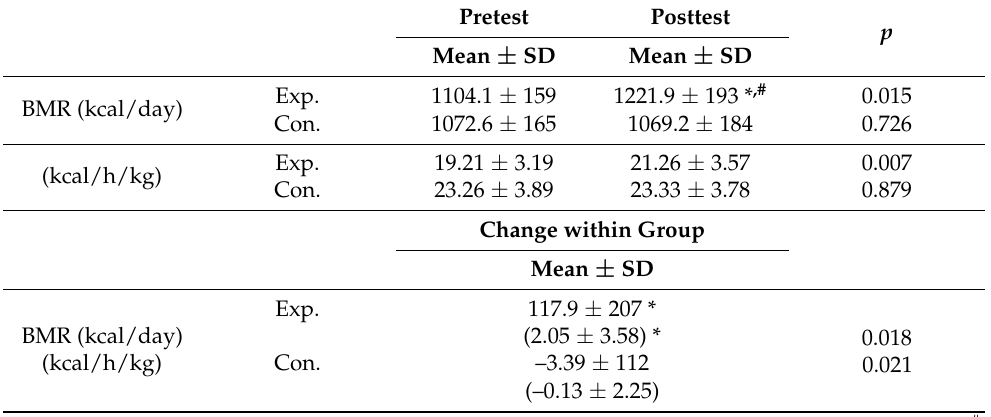
Table 5. Effects of 12-week Pilates on basal metabolic rate.